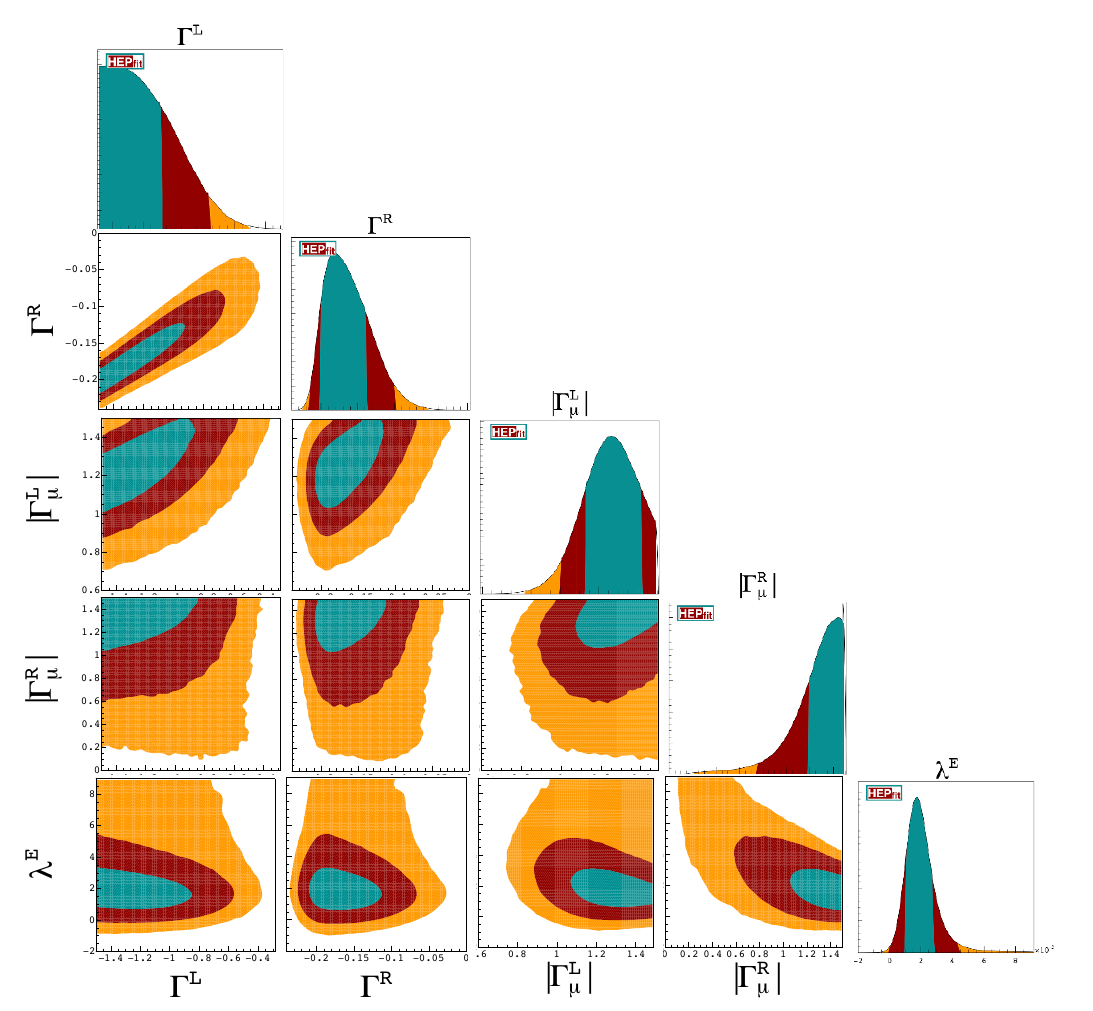
Figure 10 . The 1 D marginalized posterior distributions of the parameters from the (cid:12)t described in section 4.2, together with the 2 D correlations between them. The green, red and orange regions correspond to 68%, 95% and 99% probability regions,